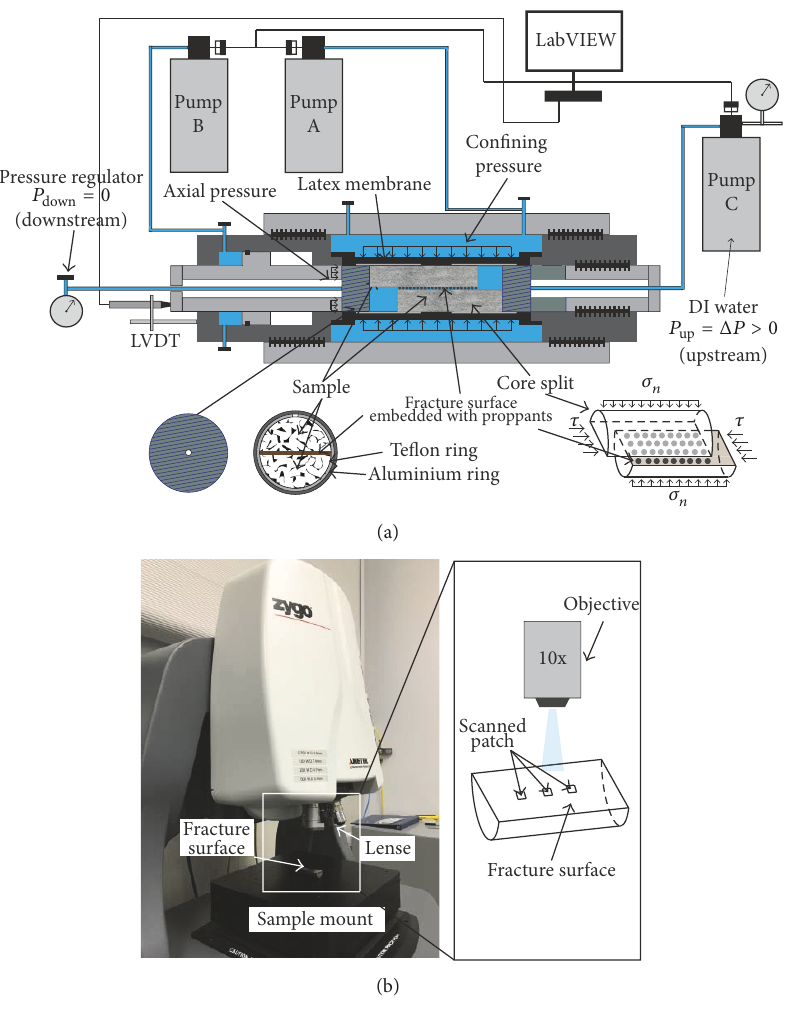
Figure 4: (a) Schematic of experimental arrangement for the measurement of evolution of permeability-friction. Pump A controls the confining pressure (normal stress) applied across the fracture. Pump B controls pressure that provides the source of shear stress applied to the fracture. Pump C injects the fluid at a prescribed flow rate or pressure, allowing the fluid source located at the origin of the fracture to flow along the fractures. (b) 3D optical surface profiler for characterizing statistical roughness of the fracture surface. The fracture surface is located ready for white light interferometric